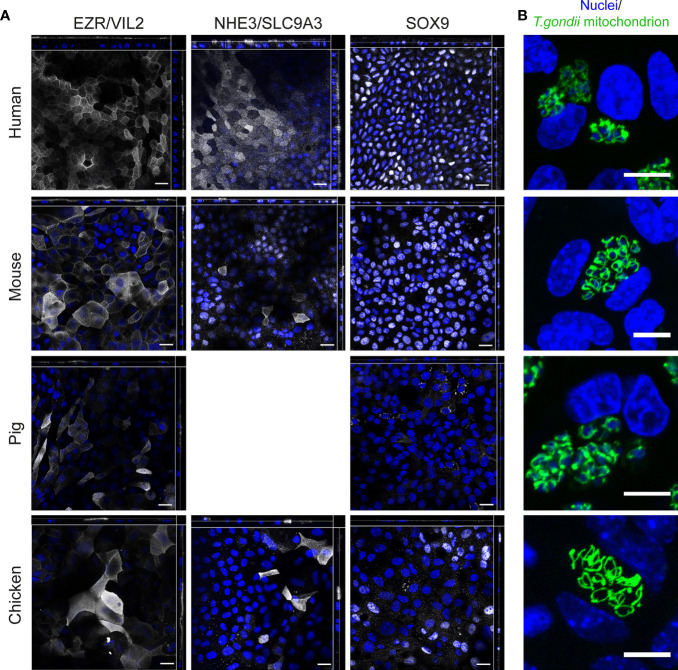
Immunofluorescence analysis of ODMs from human, mouse, pig and chicken origin. (A) Orthogonal stacks for brush border protein EZR, enterocyte marker NHE3, and SOX9. ODMs were cultured as described and fixed after 10 (human), 12 (mouse), 6 (pig) and 15 (chicken) days. Note, NHE3 analysis for pig was excluded as suitability of the antibody for IFA staining in this species is questionable (see Supplementary Figure 6). Suitability of the SOX9 antibody for IFA staining for pig is also questionable, however, the analysis was included as the antibody target sequences are highly similar between species (see Supplementary Figure 6). Representative fluorescent orthogonal stacks of ODMs are shown. Scale bars represent 20 µm. (B) Representative confocal image projections of ODMs infected for 48 h with T. gondii (distinguished by its GFP-tagged green tubular mitochondria) in TYI-S-33 medium. Scale bar 10µm. All experiments were performed at least twice with similar results.